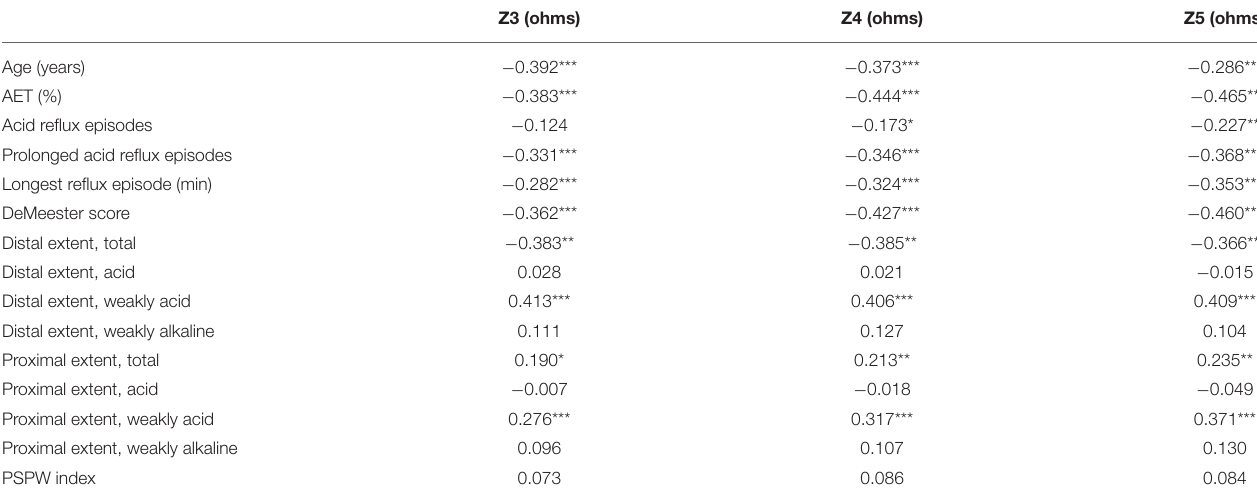
TABLE 4 | MNBI values associations of age, reflux episodes, and PSPW index.